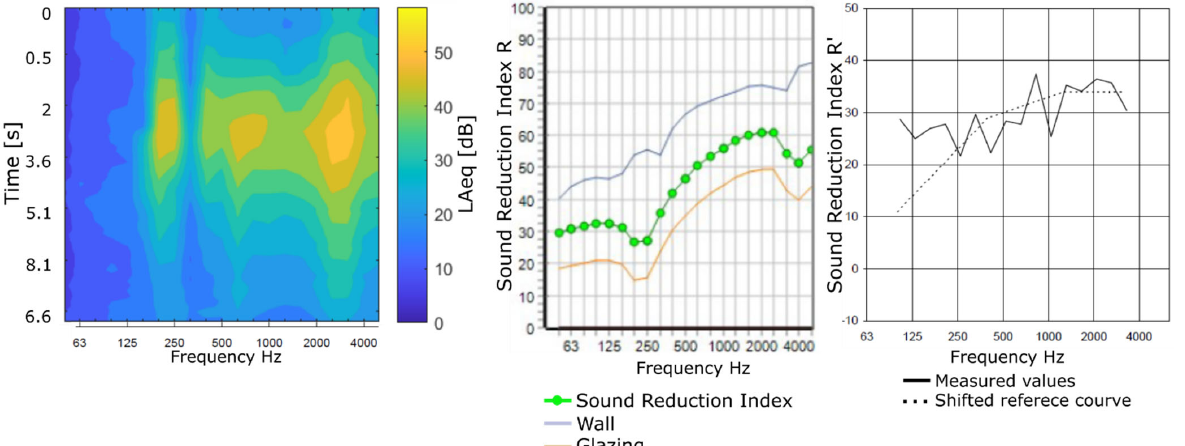
Figure 6. LA max for the drone Typhoon during fast flyover operations ( left ); adapted with permission from Ref. [18]. Sound reduction index of a 70 mm PVC-U bottom hung inward tilt window 4-16-4 mm (0.94 m 2 ; 26.00 kg/m 2 ). Predicted 𝑅 by INSUL software ( middle ) and measured 𝑅′ ( right ); reprinted with permission from Ref. [32]. Note that “shifted reference curve” is the specific term used in [31] for obtaining a single value from frequency ‐ dependent sound reduction index.